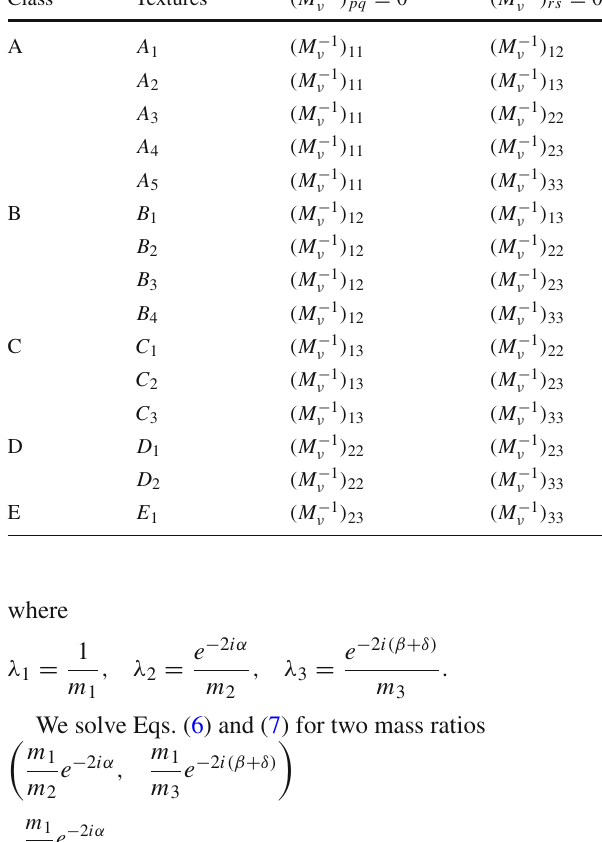
Table 1 Fifteen possible two-zero texture patterns with corresponding first and second zero Class